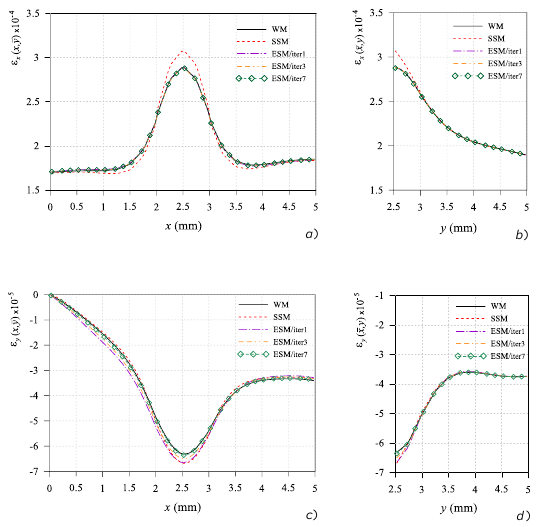
Figure 3: Nonlocal plate of figure 1. Strain components profiles ε x and ε y versus x at y (cid:119) 2.5 on the left side and versus y at x (cid:119) 2.5 on the right side. Solutions computed on the whole model (WM) of the plate (solid lines); solutions computed on the (half-structure) standard symmetric model (SSM) of the plate (dash lines); solutions computed on the enlarged symmetric model (ESM): at iteration 1 (dash-dot lines), at iteration 3 (double dash-double dot lines) and at iteration 7 (dash line with diamonds).